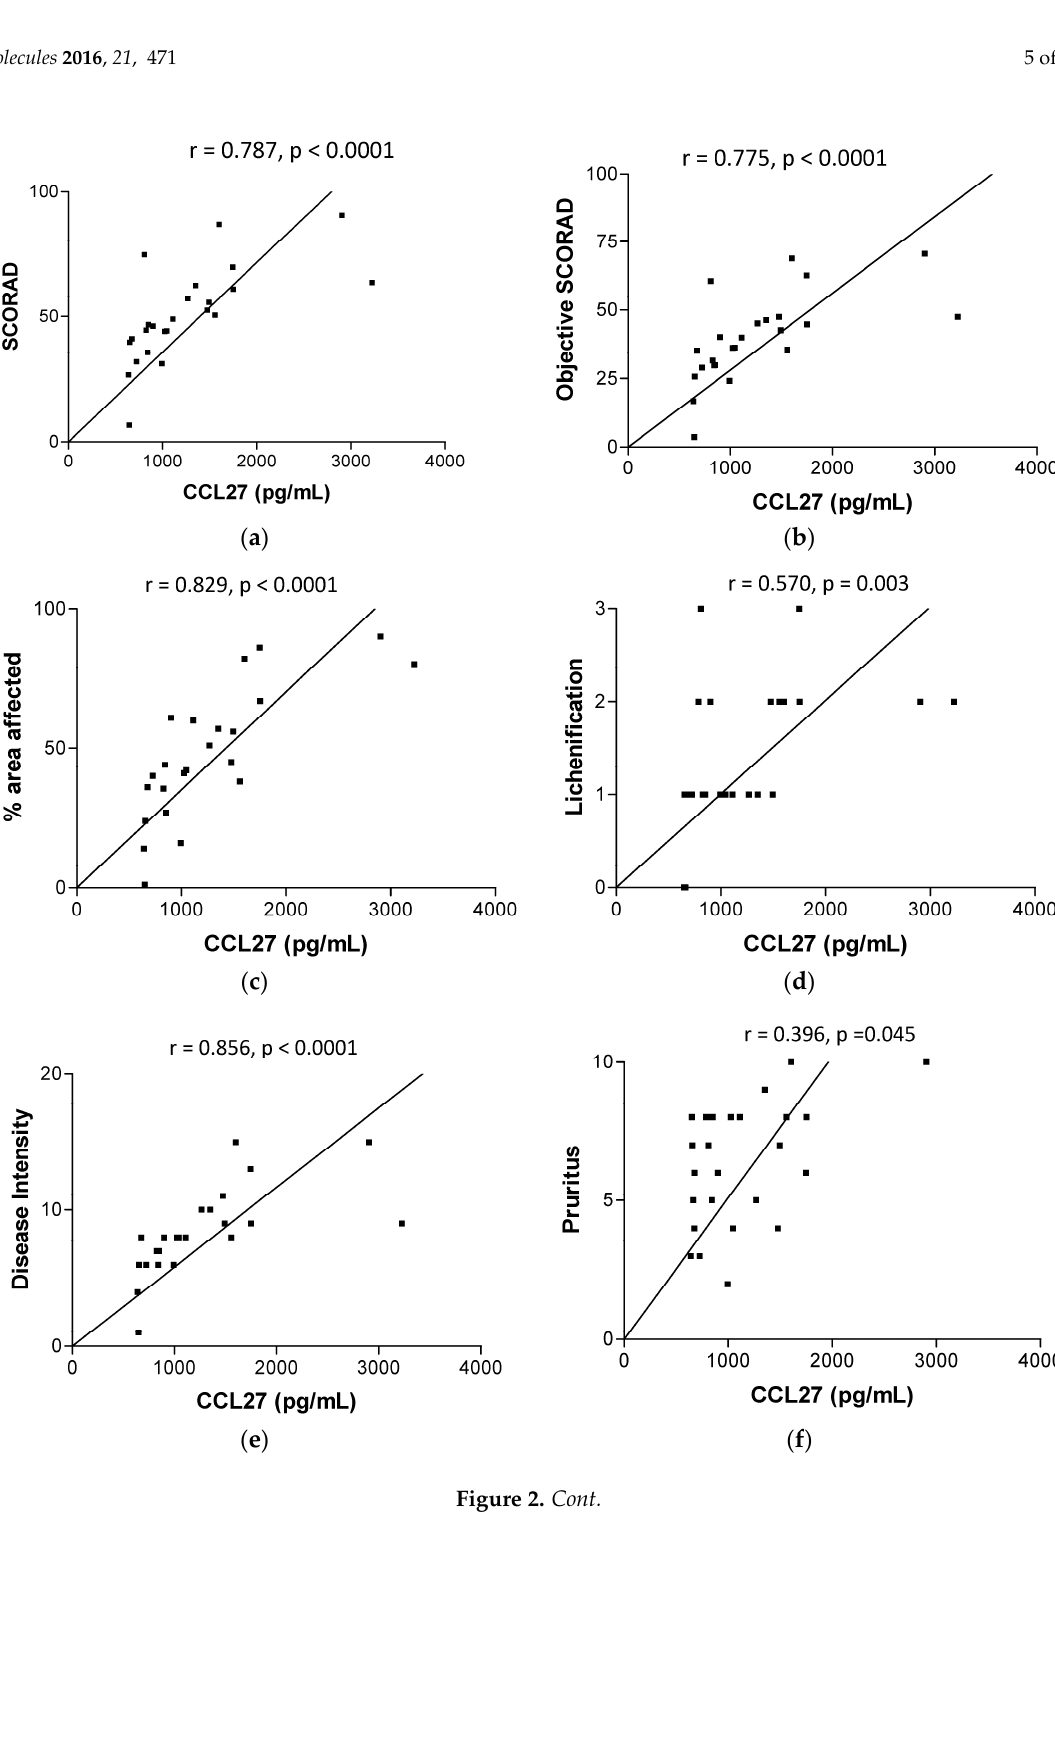
Figure 1. Plasma concentrations of CCL27, CCL22, CCL17, HNP and dermcidin in AD patients and normal controls. Box and whiskers plots showing comparisons of plasma concentrations of ( a ) CCL27, ( b ) CCL22; ( c ) CCL17; ( d ) HNP and ( e ) dermcidin between AD patients and control subjects were determined by Mann-Whitney rank sum test.